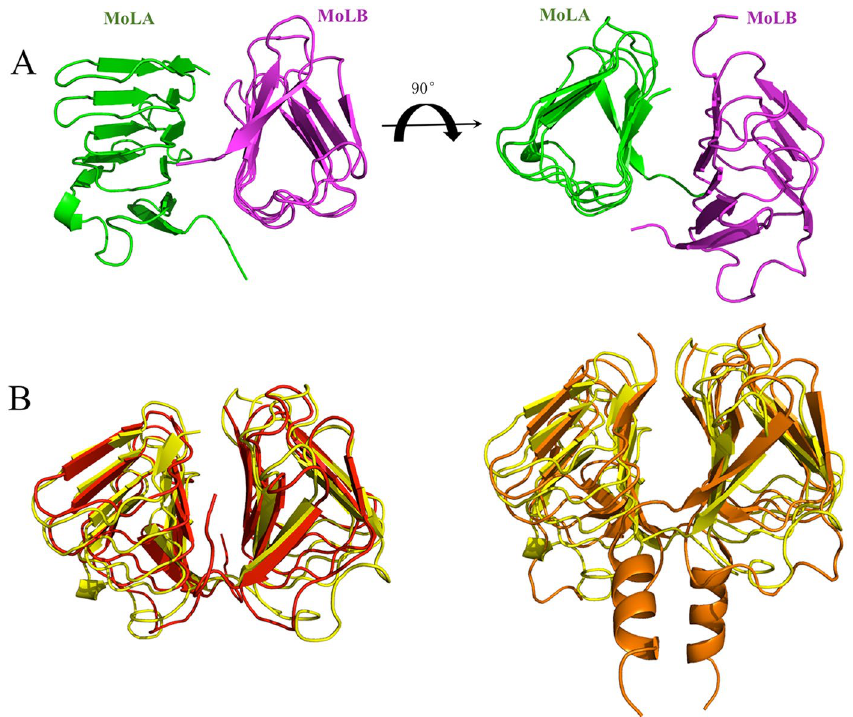
Figure 1. Overall structure of the dimeric MinC C-terminal domain from E. coli ( Ec MinC CTD ). ( A ) The ribbon diagrams of two monomers are in green and magenta. ( B ) Left: structural comparison of Ec MinCCTD (yellow) and the Tm MinC C-terminal domain ( Tm MinCCTD, red). Right: structural comparison of Ec MinCCTD (yellow) and the Aa MinC C-terminal domain ( Aa MinCCTD, orange). Superimposition was performed using the program PyMOL